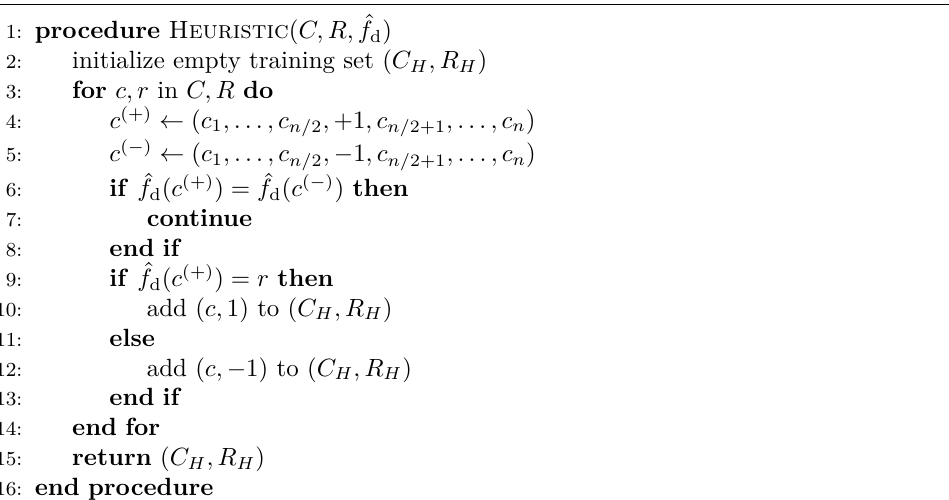
Algorithm 1 Heuristic for creating upper-layer training